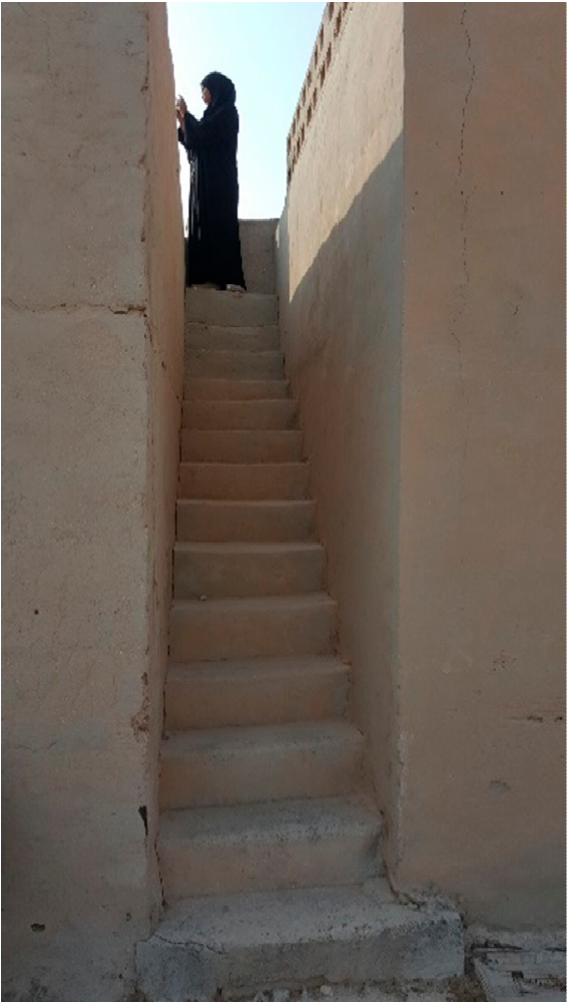
Figure 10. Staircase in house #9 in between the southern